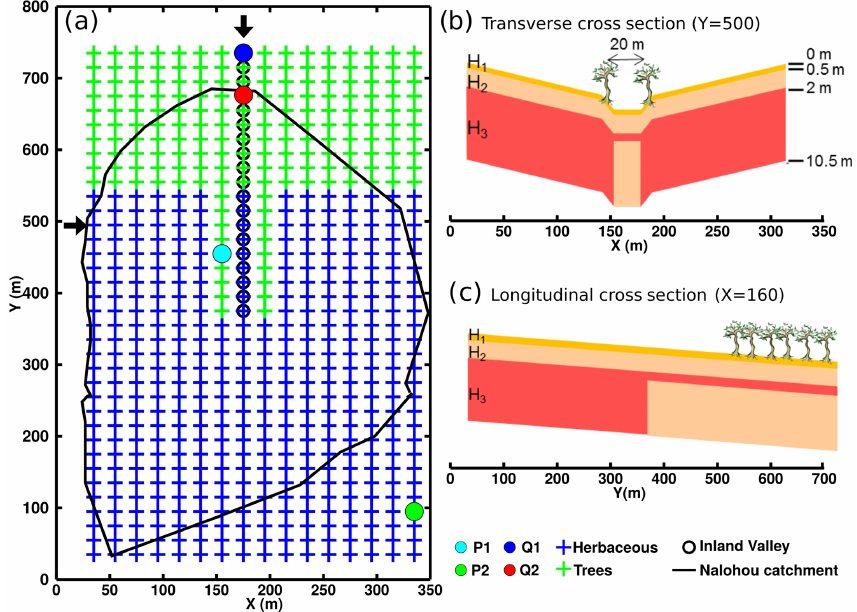
Figure 1. (a) Catchment mesh. Blue and green crosses indicate the vegetation distribution for the reference case. Inland valley cells are shown as black circles. P are water table sampling locations and Q are streamflow sampling locations. (b, c) Domain cross sections schematically made up of three soil types: high-permeability sandy soils (yellow), hardpan or fissured basement (orange) and low-permeability clay accu- mulation